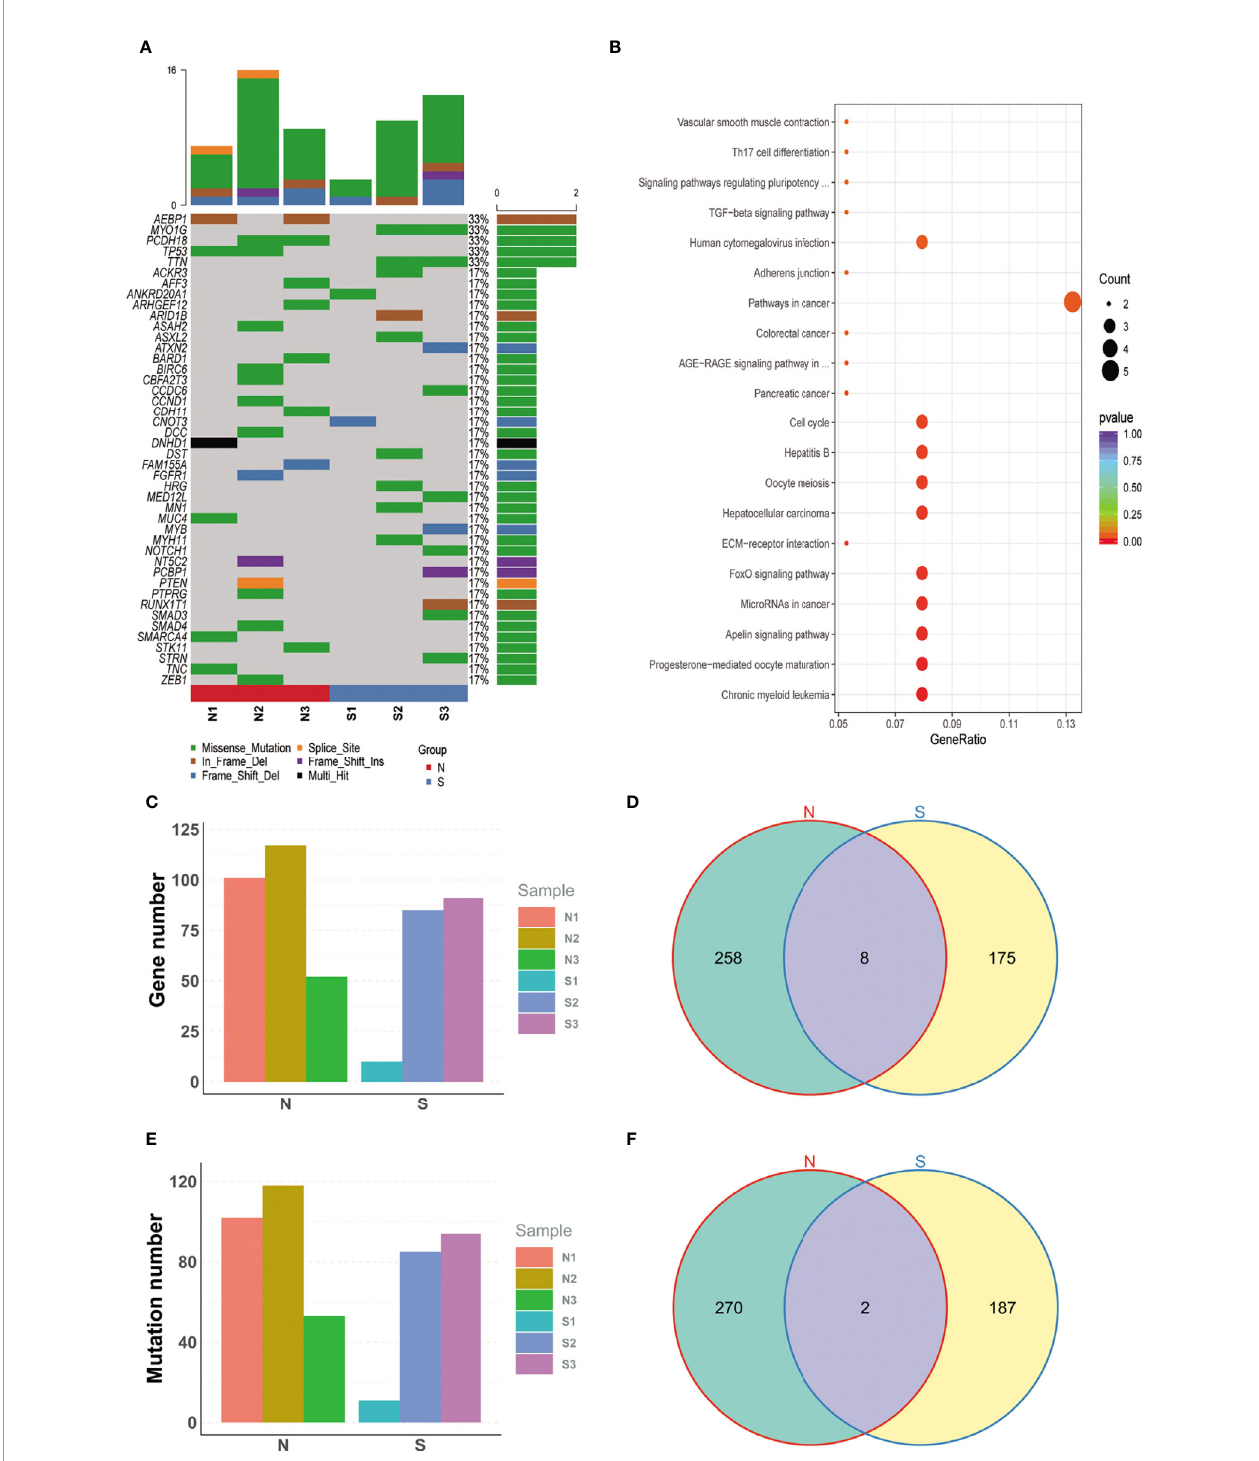
FIGURE 2 | Speci fi c mutated genes between group N and group S. (A) The oncoprint plot of all somatic mutations. (B) The bubble chart of kegg terms enriched for all diff-mutated genes. (C) No signi fi cant difference on total number of genes was observed between group N group and group S. (D) There are 8 common genes in both groups, as well as 258 and 175 unique genes belonged to the group N and group S, respectively. (E) No signi fi cant difference on total number of variations was observed between group N and group S. (F) 2 common mutations were shared in both groups, but 270 and 187 unique mutations belonged to the group N and group S,